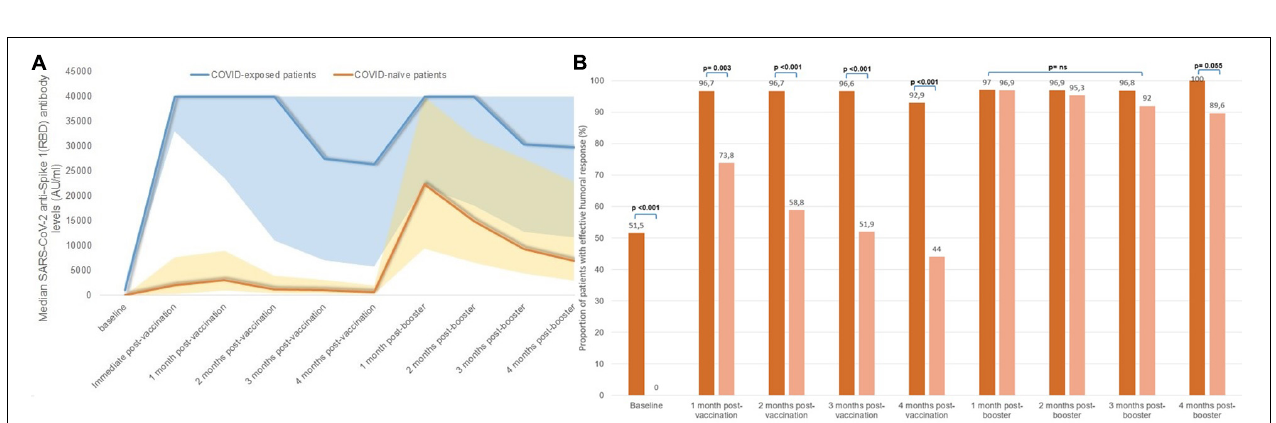
FIGURE 4 | Serological changes according to SARS-CoV-2 exposure status: (A) median monthly anti-S(RBD) antibody levels, (B) proportion of patients with effective humoral response after vaccination according to prior SARS-CoV-2 exposure.